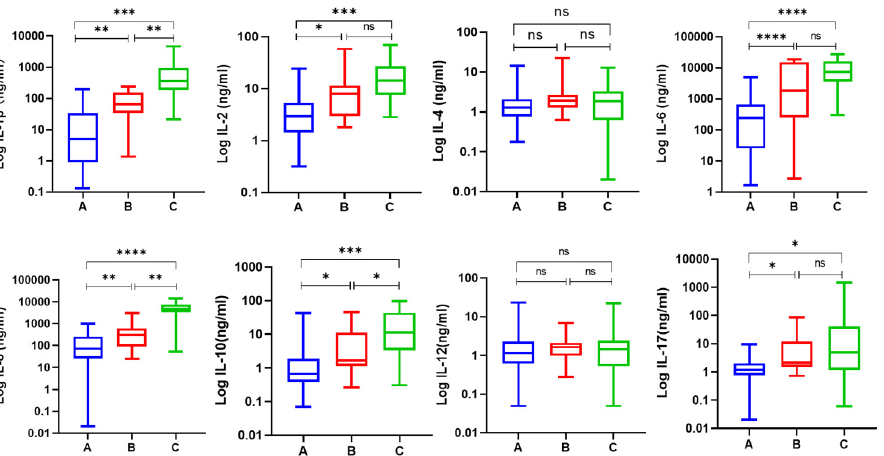
Figure 1. Scatterplots showing the concentration of each biomarker in the three groups. ns, not sig- nificant. * p -value < 0.05; ** p -value < 0.01; *** p -value < 0.001; **** p -value <